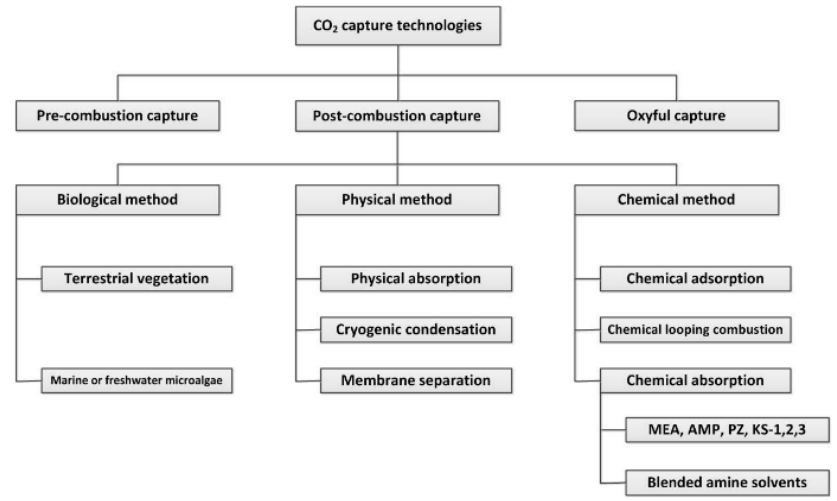
Figure 10. Technology options for CO 2 capture